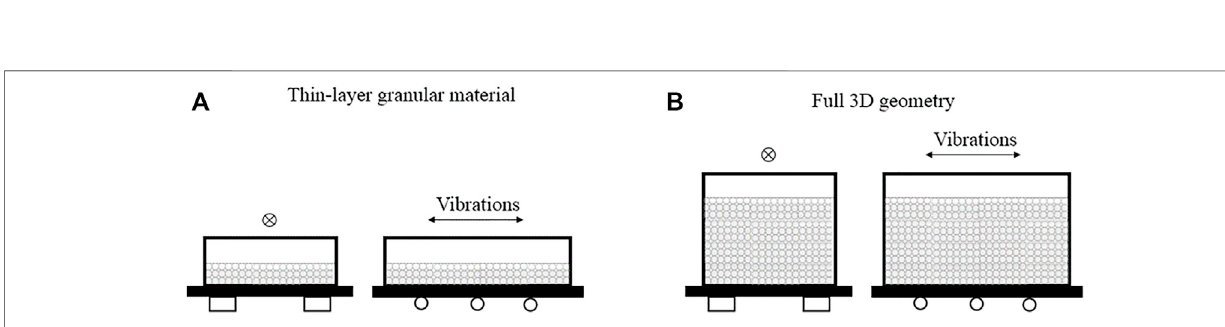
Frontiers in Built Environment |